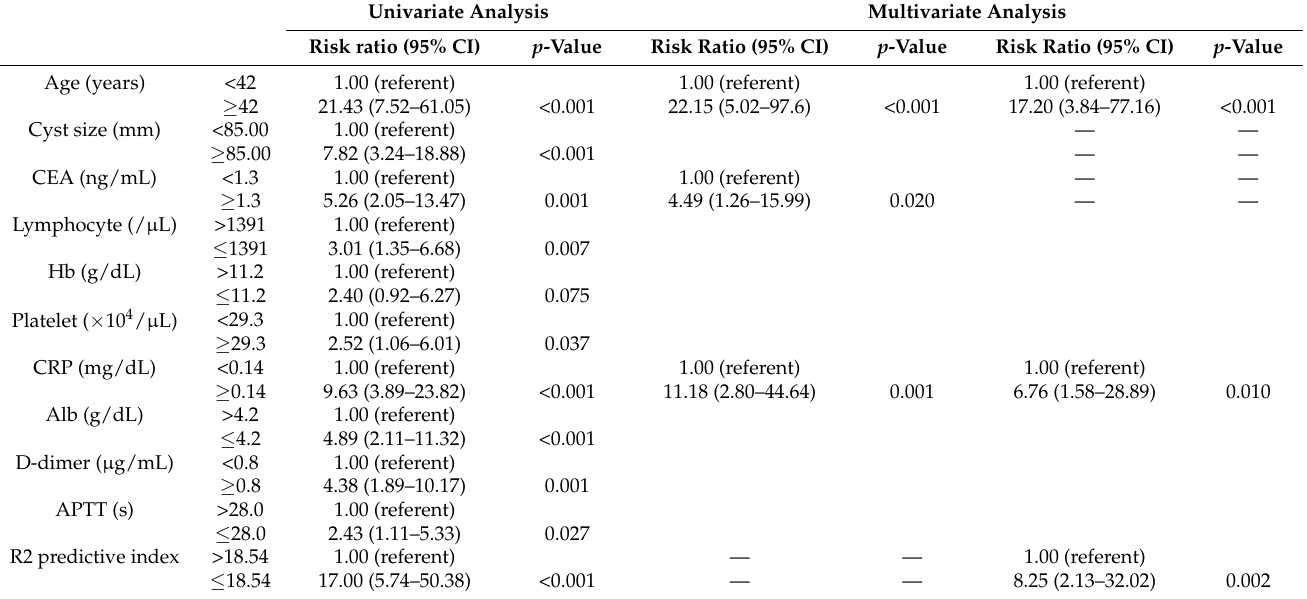
Table 4. Univariate and Multivariable analysis of the predictive factors of EAOC in the validation cohort. Univariate Analysis Multivariate